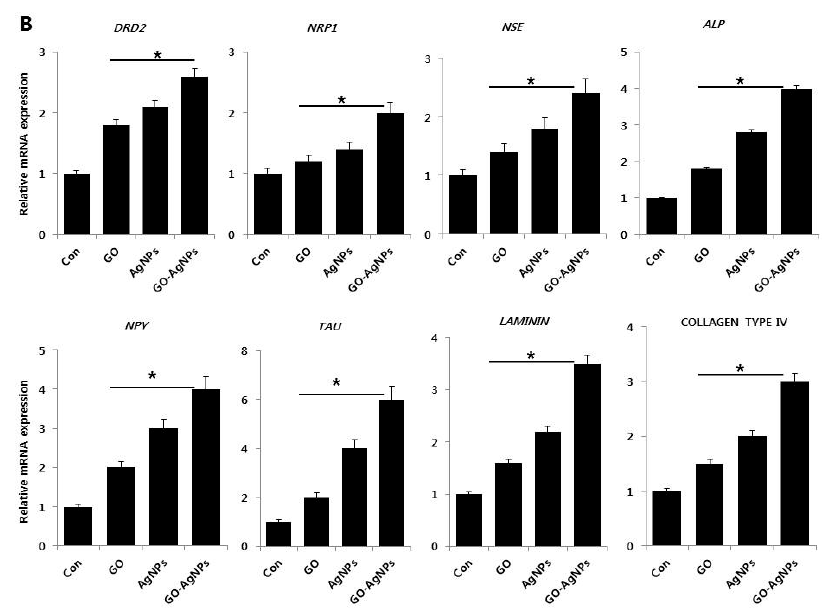
Figure 5. ( A ) Reverse transcription-quantitative polymerase chain reaction (RT-qPCR) analysis of expression of various neuronal markers. Microtubule-associated protein 2 ( MAP2 ), synaptophysin, neurofascin ( NFASC ), protein kinase C, alpha ( PRKCA ), β tublin III, fox-1 homolog 3 ( NEUN ), growth associated protein 43 ( GAP-43 ) and neurogenin 1, were analyzed after exposure of SH-SY5Y cells to GO (10 µg/mL), AgNPs (5 µg/mL) and GO-AgNPs (1.0 µg/mL) for 24 h. After 24 h treatment GAPDH; ( B ) Reverse transcription-quantitative polymerase chain reaction (RT-qPCR) analysis of expression dopamine receptors type 2 ( DRD2 ), neuropilin 1 ( NRP1 ), gamma neuronal ( NSE ), alkaline phosphatase ( ALP ), neuropeptide Y, ( NPY ), microtubule-associated protein tau ( TAU ), laminin, and collagen type